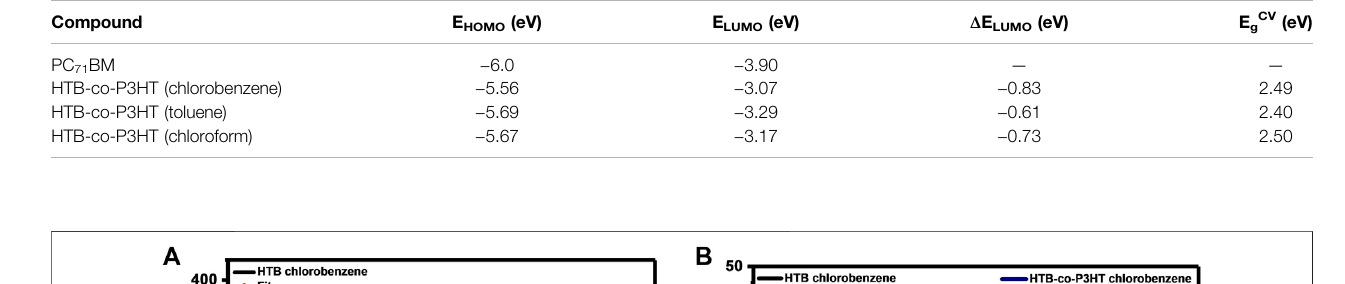
Frontiers in Materials |